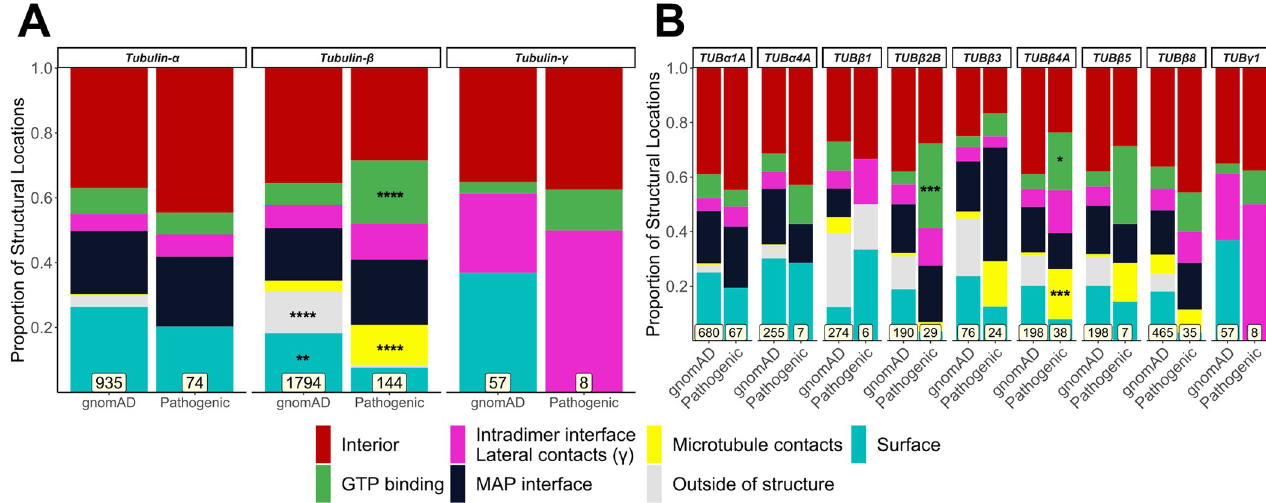
Fig 1. Comparison of the distribution of structural locations between pathogenic and putatively benign tubulin variants. The proportion of pathogenic and putatively benign gnomAD mutations in each location type for tubulin- α , β and γ globally (A) and for individual isotypes (B) . Mutation totals for each group are shown at the bottom, and only isotypes with at least five pathogenic mutations were included. Fisher’s exact tests were used to compare frequencies between gnomAD and pathogenic mutations considering each family and isotype separately. Asterisks indicate a location class with a significantly higher proportion of mutations compared to its corresponding group, where � p < 0.05, �� p < 0.01, ��� p < 0.001, ���� p < 0.0001.